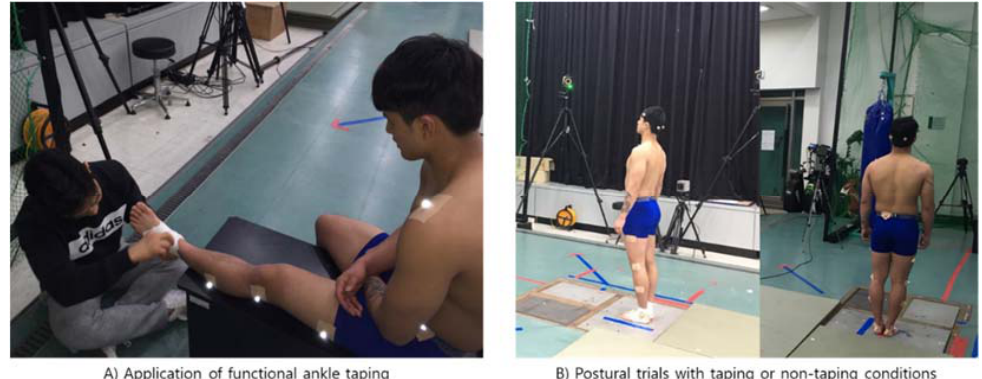
Figure 1. Experimental protocol of the ankle taping intervention and postural standing trials on a force plate mounted on the laboratory